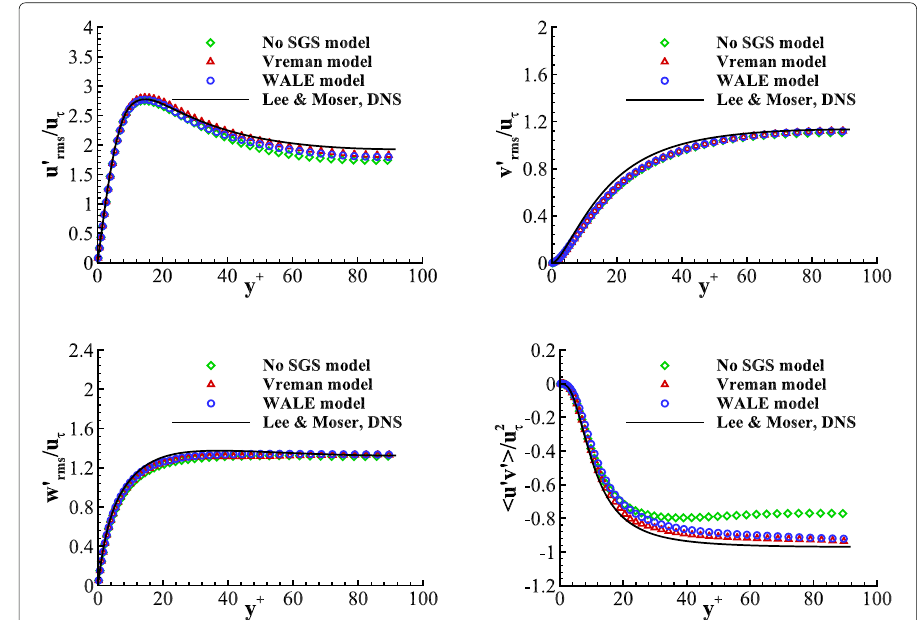
Fig. 11 The r.m.s. velocity fluctuations and Reynolds stress for the turbulent plane Couette flow at Re τ = 93. a the r.m.s. streamwise velocity fluctuation, b the r.m.s. wall-normal velocity fluctuation, c the r.m.s. spanwise velocity fluctuation, d Reynolds